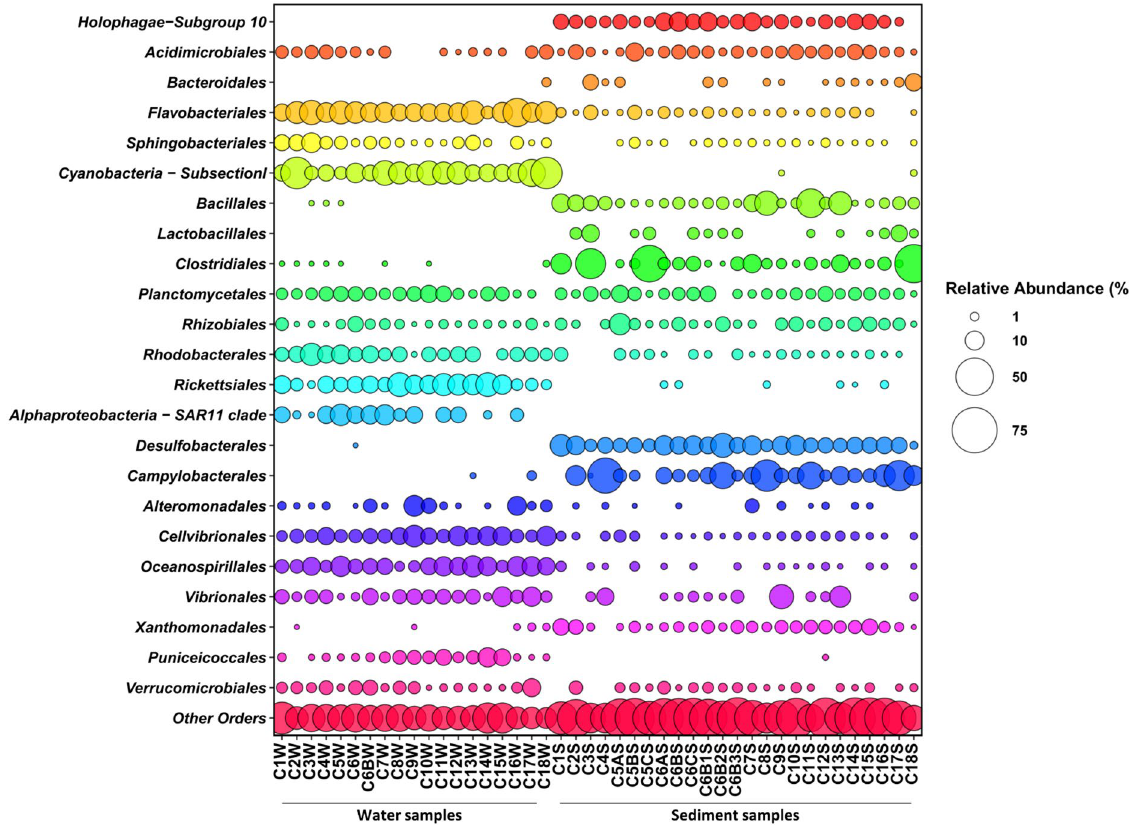
Figure 2. Bubble chart showing the relative abundance of major orders (r.ab. > 5% in at least two samples) in the water samples (left part of the graph) and sediment samples (right part of the